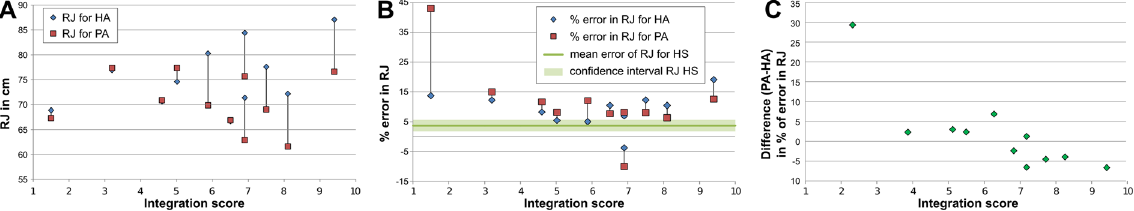
Figure 3. ( A ) Reachability judgement (in cm) for the healthy and prosthetic arms of the patients as a function of the integration score. ( B ) Reachability judgement error (in%) for the healthy and prosthetic arms of the patients as a function of the integration score. Reachability judgement error of healthy subjects (and its confidence interval) is also shown on the plot. ( C ) Difference of the reachability judgement error between the healthy and prosthetic arms as a function of the incorporation score, for 11